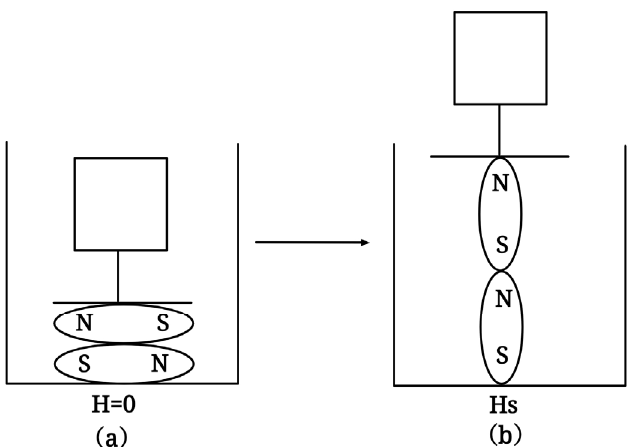
Figure 7. Two-dimensional schematic diagram of magnetostrictive effect: ( a ) No applied magnetic field; ( b ) an external magnetic field is applied.